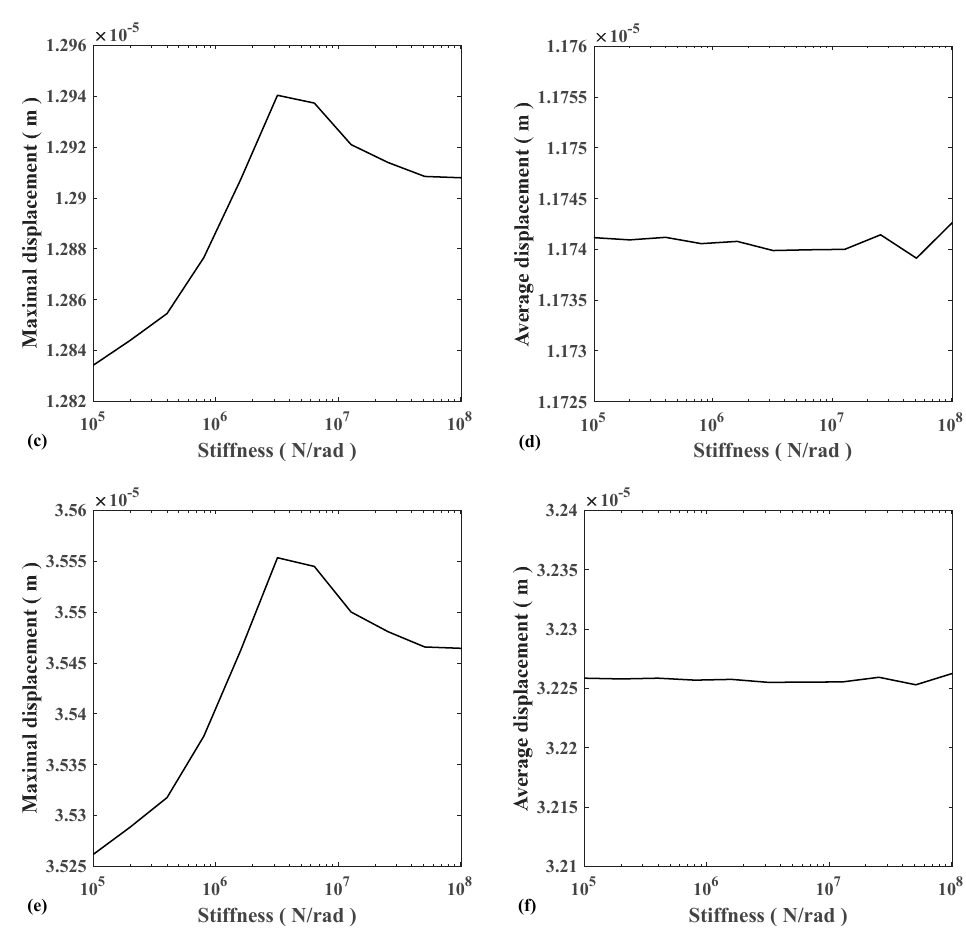
Figure 18. ( a ) Gear1 maximal angular velocity; ( b ) Gear1 average angular velocity; ( c ) Gear1 X -direction maximal displacement; ( d ) Gear1 X -direction average displacement; ( e ) Gear1 Y -direction maximal displacement; and ( f ) Gear1 Y -direction average displacement;.